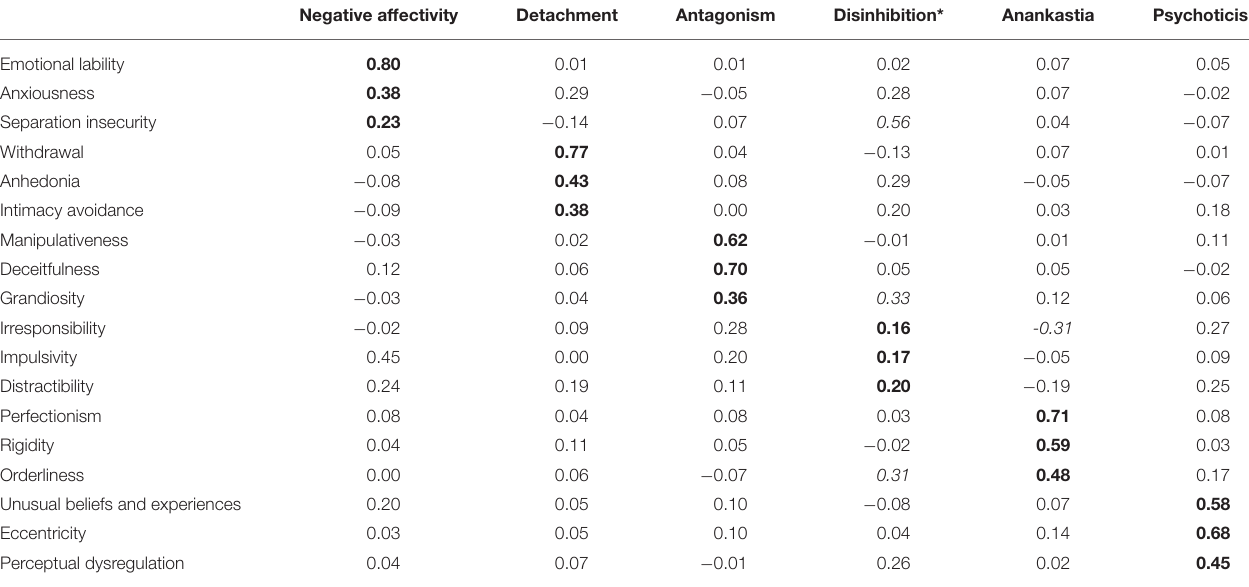
TABLE 2 | Loadings patterns of the facets derived from the independent version of PID5BF + M.